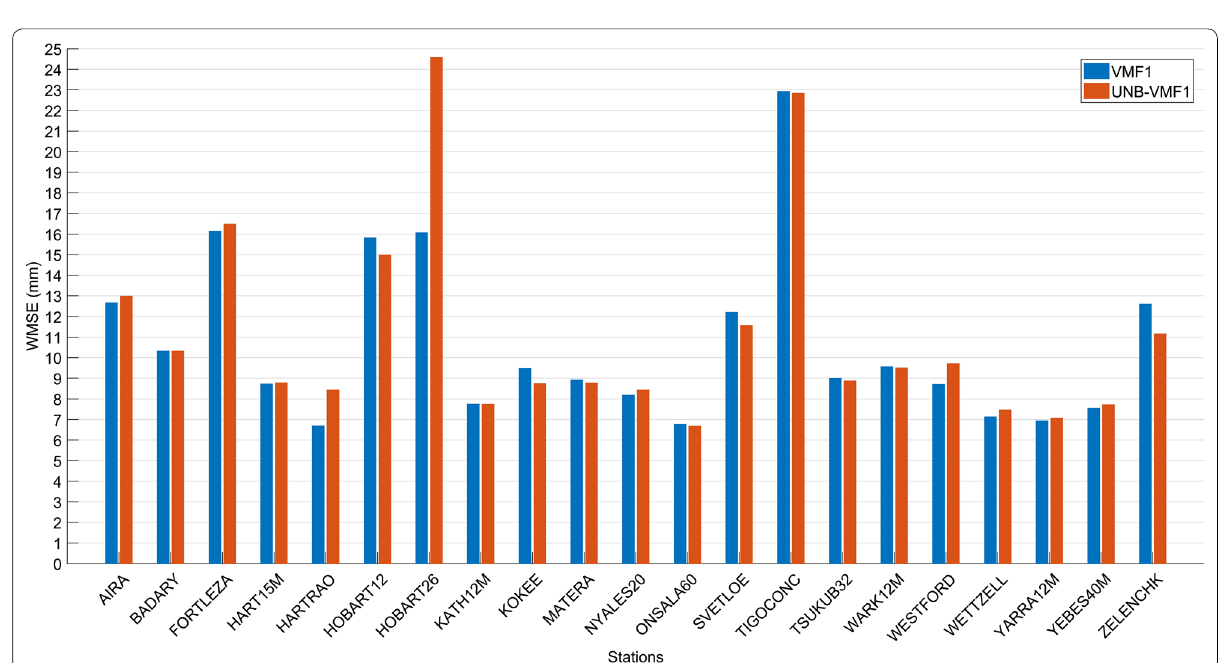
Fig. 12 VLBI PDA stations’ height component wrms in